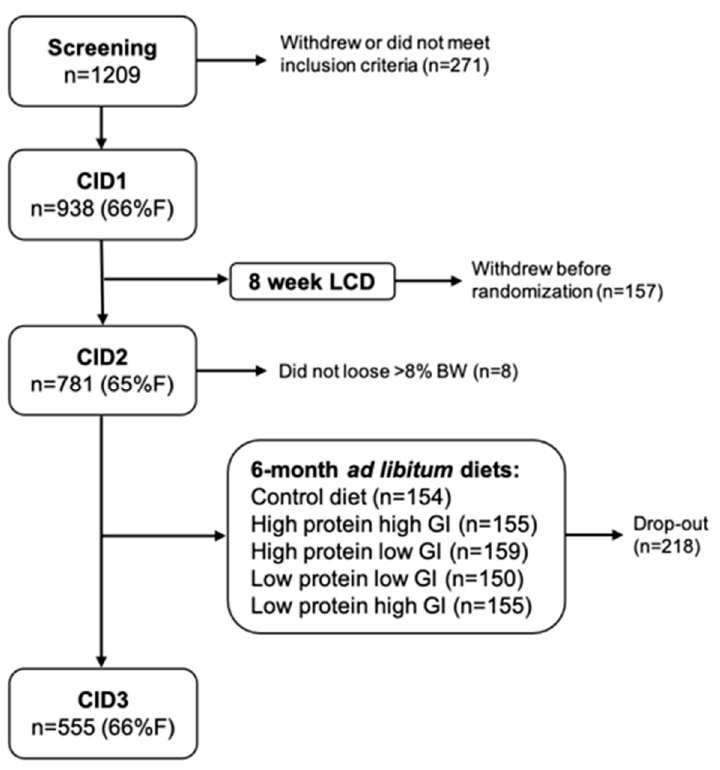
Figure 1. Schematic overview of participant inclusion and study design of the DiOGenes study. %F = percentage of females.